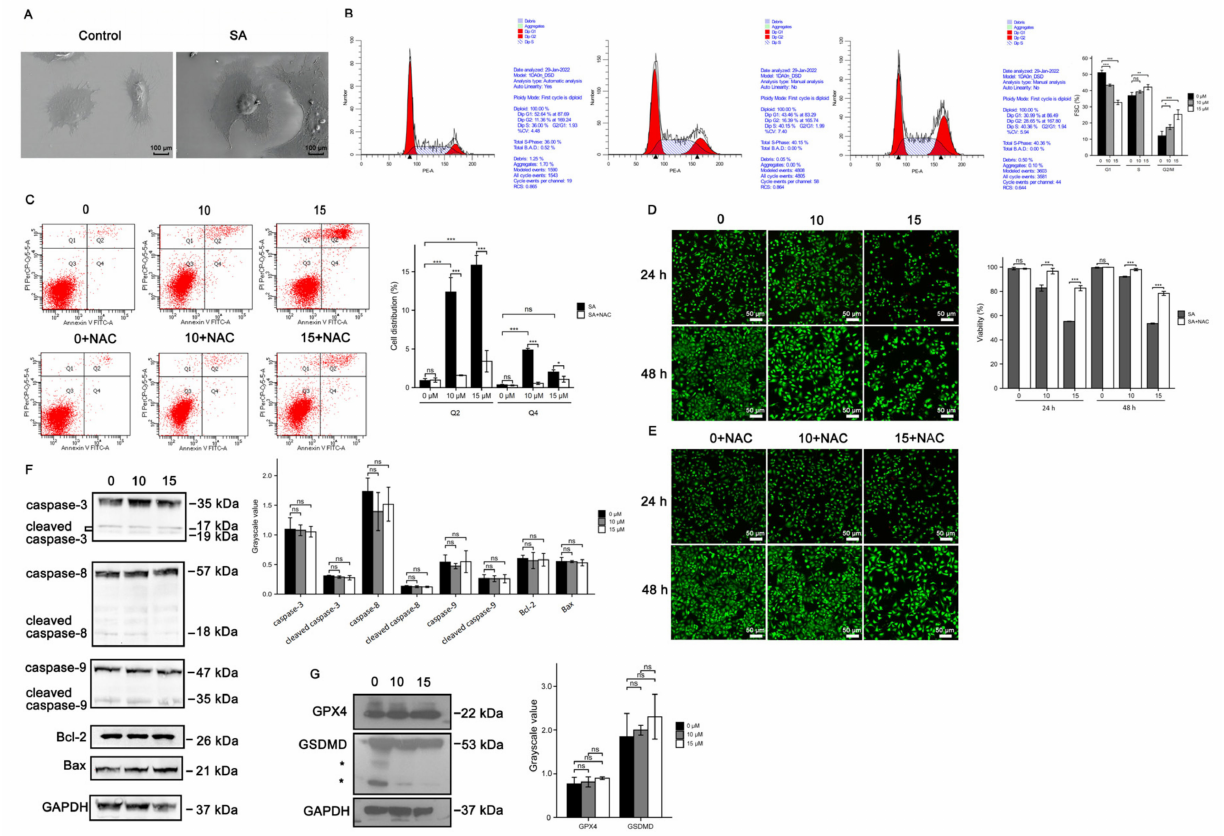
Figure 3. Cell death induced by scabertopin treatment can be rescued by NAC. ( A ) SEM images show that, in J82 cells treated for 24 h with 10 µ M of scabertopin, the cell spreading area increases and the cell pseudopods shorten and thin out. The 24 h scabertopin treatment induces cell cycle arrest ( B ) and death ( C ) in J82 cells in a concentration-dependent manner (the black arrowheads in Figure 3B indicate the values of the peaks). The live/death cell assay shows scabertopin inhibits the viability of J82 cells after 24 and 48 h of treatment ( D ), and this effect can be reduced by NAC treatment ( E , F ). The expression levels of the apoptosis-related proteins caspase-9, caspase-8, caspase-3, Bax, and Bcl-2 in J82 cells do not significantly change after 24 h of scabertopin treatment. ( G ). Scabertopin does not significantly alter the expression of the ferroptosis- and pyroptosis-related proteins GPX4 and GSDMD, respectively, in J82 cells after 24 h treatment. A total of 5 µ M of NAC was used in the experiments, * means nonspecific bands. Data represent the mean ± s.e.m. of the three independent experiments. * p < 0.05; ** p < 0.01; *** p < 0.001, ns: no significance vs. 0 µ M scabertopin-treated group. The grayscale values are normalized to GAPDH. Bax: Bcl-2-associated X; Bcl-2: B cell lymphoma-2; GPX4: glutathione peroxidase 4; GSDMD: Gasdermin-D; NAC: N -acetylcysteine; PE-A: phycoerythrin area; PerCP-Cy5-5-A: Peridinin-Chlorophyll-Protein Complex-Cyanine5.5 area; SA: